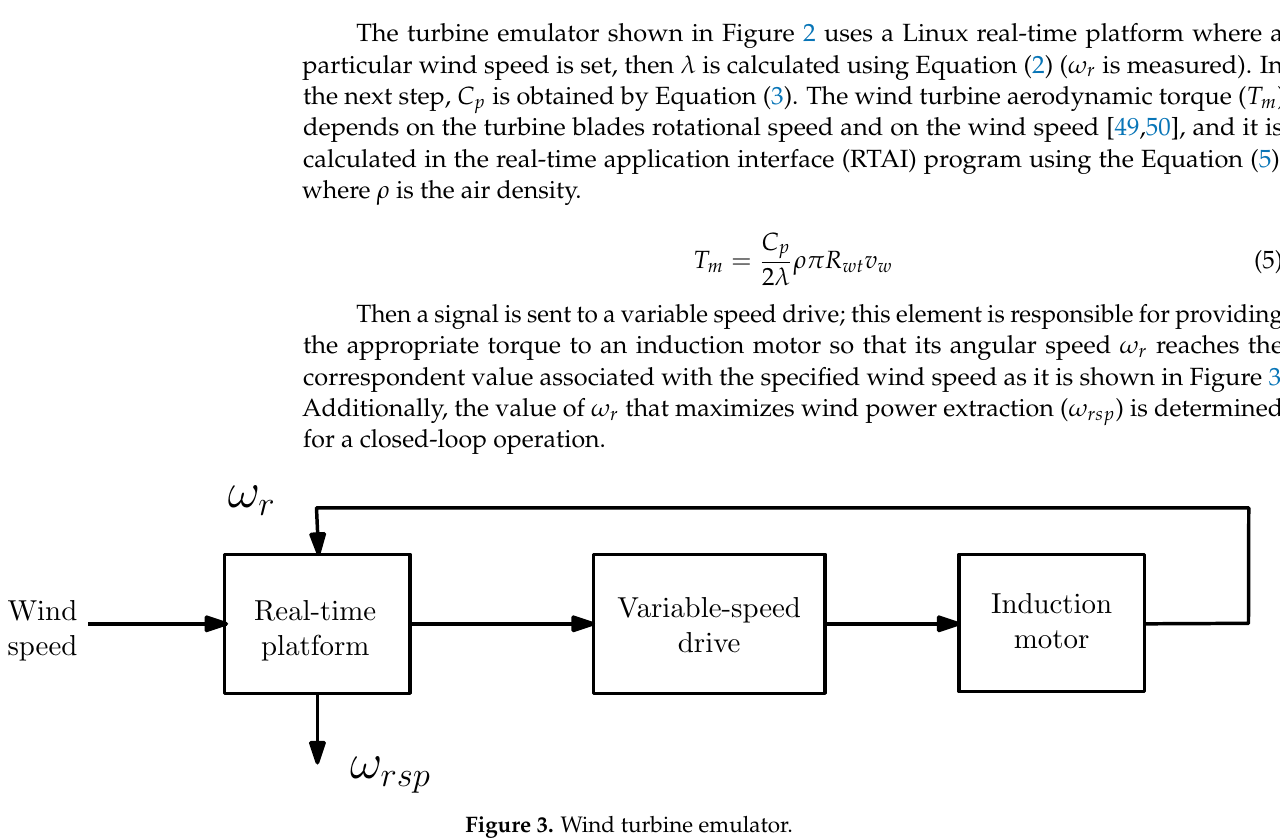
Figure 2. General overview of the WECS used in this research.